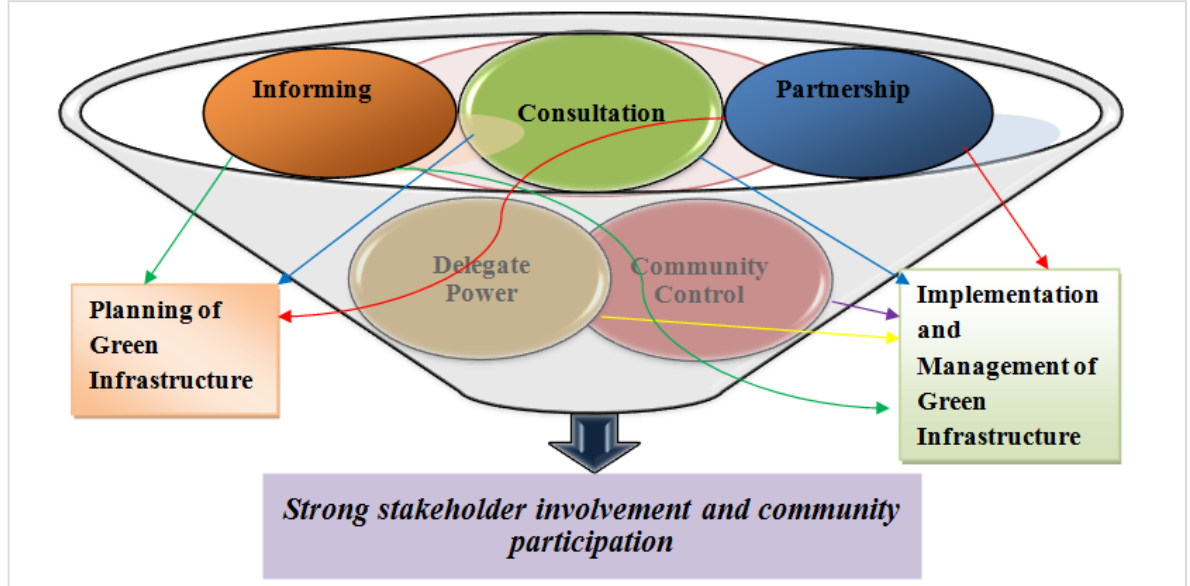
Figure 5. Approaches that strengthen the stakeholders’ involvement and community participation.